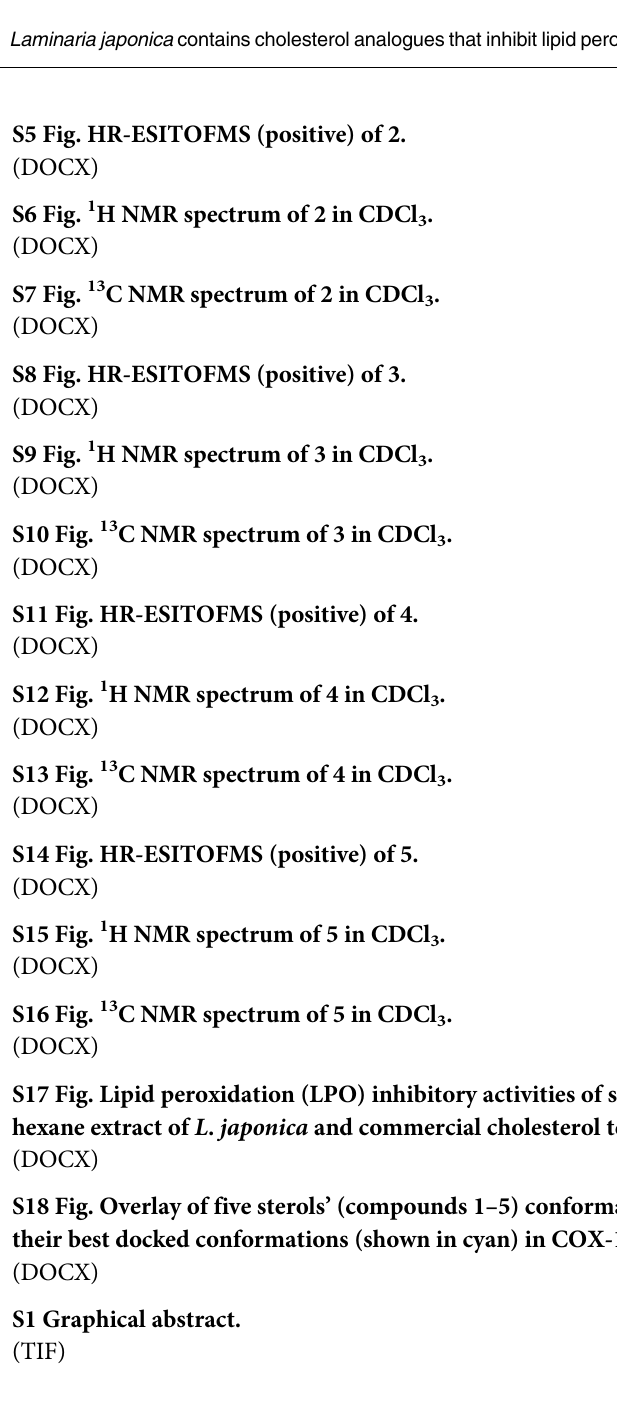
S5 Fig. HR-ESITOFMS (positive) of 2. (DOCX) S6 Fig. 1 H NMR spectrum of 2 in CDCl (DOCX) S7 Fig. 13 C NMR spectrum of 2 in CDCl